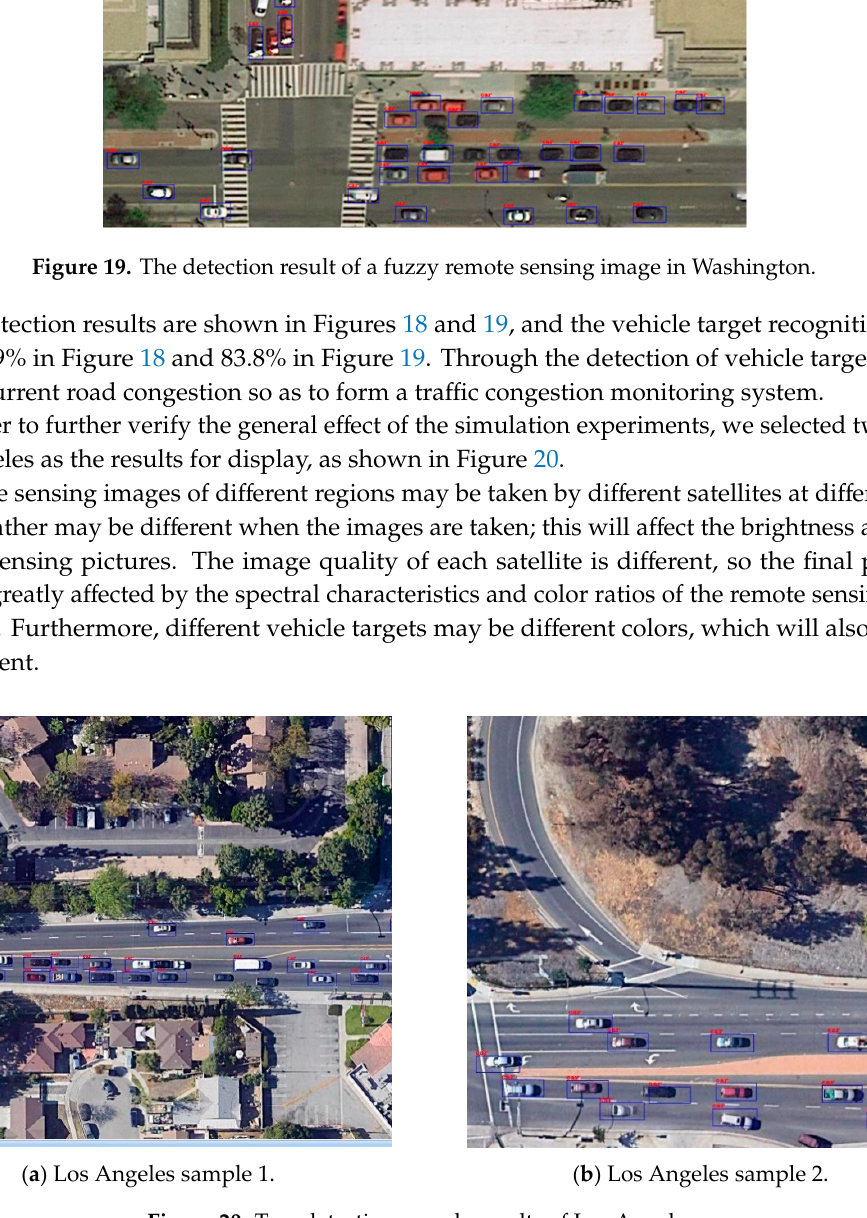
Figure 20. Two detection sample results of Los